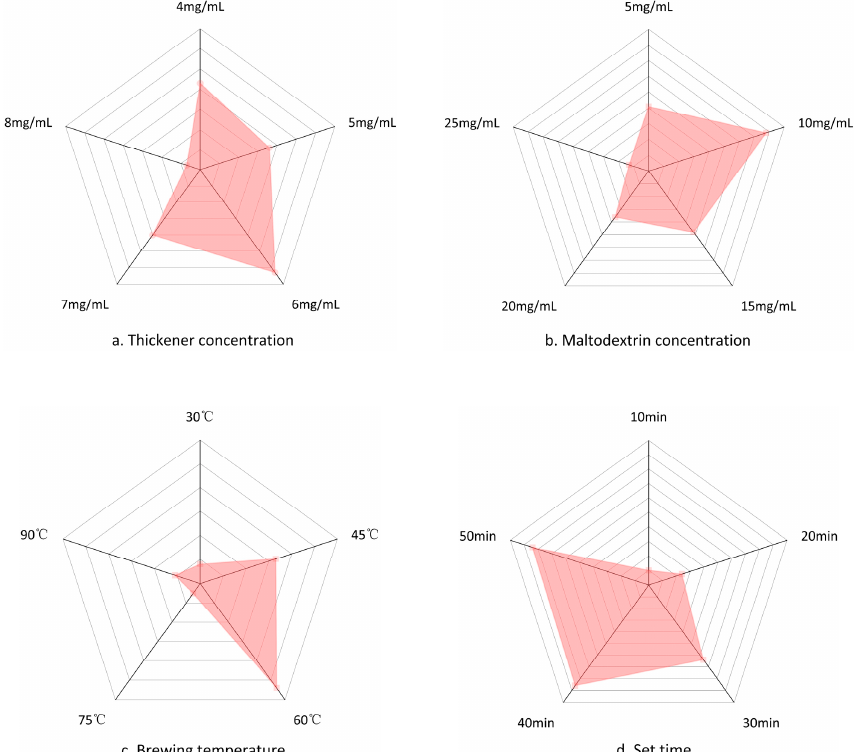
Figure 10. Effect of four factors on sensory scores of thickening components: ( a ) thickener concentration; ( b ) maltodextrin concentration; ( c ) brewing temperature; ( d ) set time.